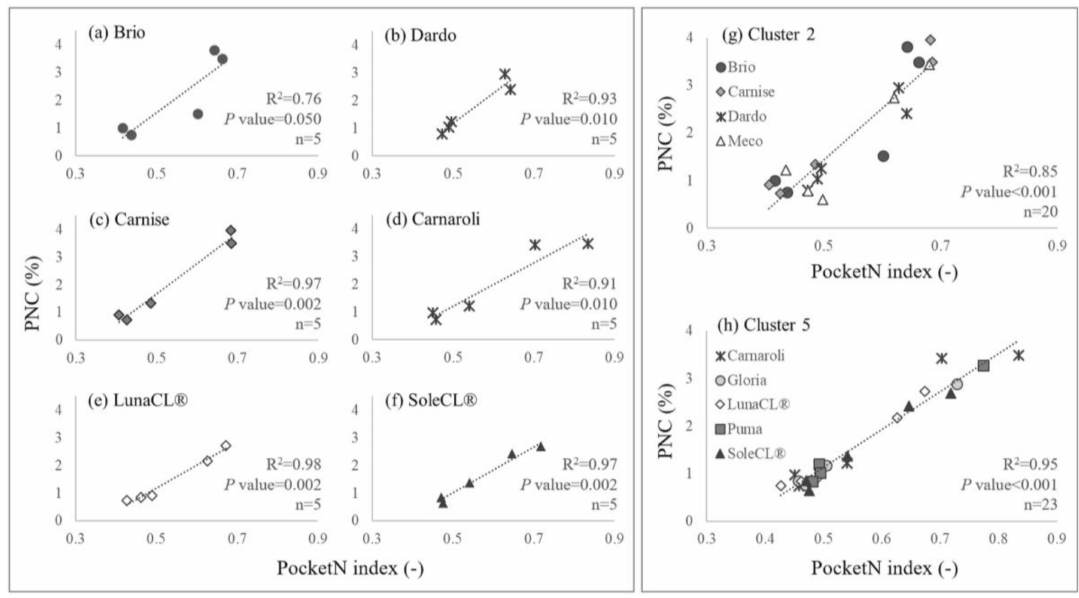
Figure 3. Examples (charts for all other calibration curves are available in Appendix A) of the relationships between the PocketN index (–) and reference plant nitrogen content (PNC) (%, from elemental analyzer) for six widely grown cultivars and for two groups of cultivars after clustering the calibration curves. See also Tables 1 and 2. Table 2. Rice varieties in each cluster and corresponding cluster-specific calibration curves to convert PocketN readings (–) into plant nitrogen content (PNC, %)